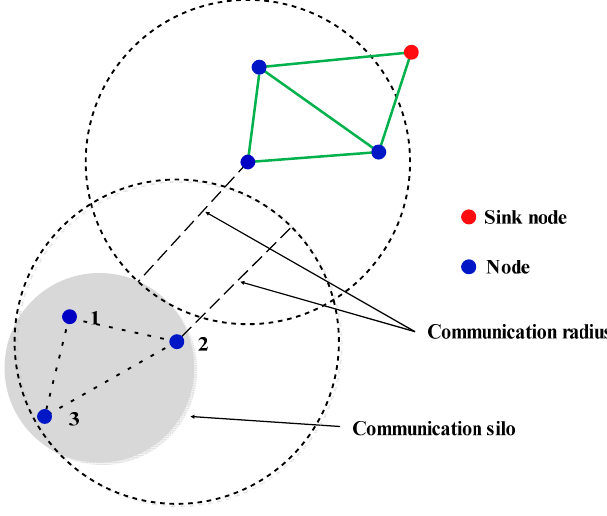
Figure 6. There was a communication silo in this k -connected network.